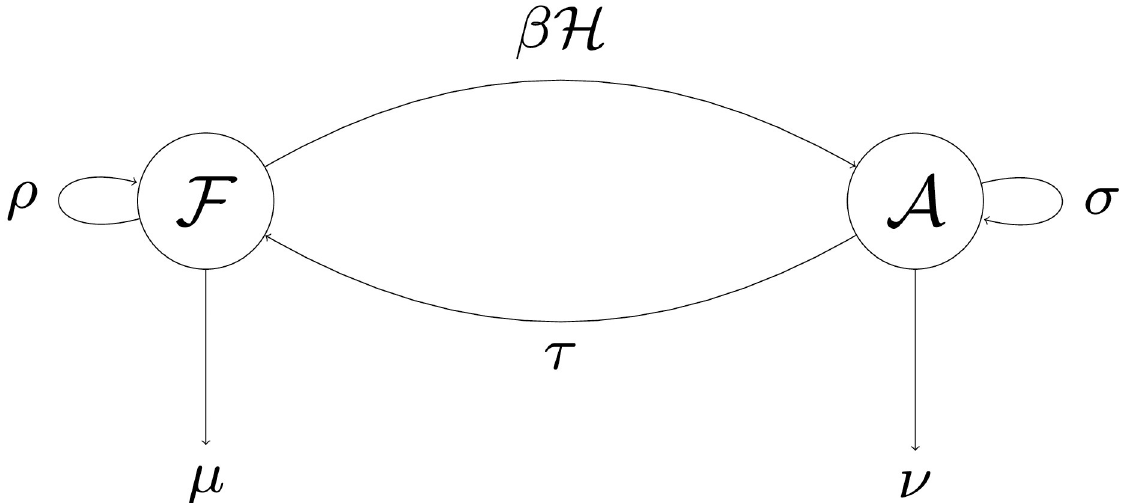
Fig 1. Schematic representation of the